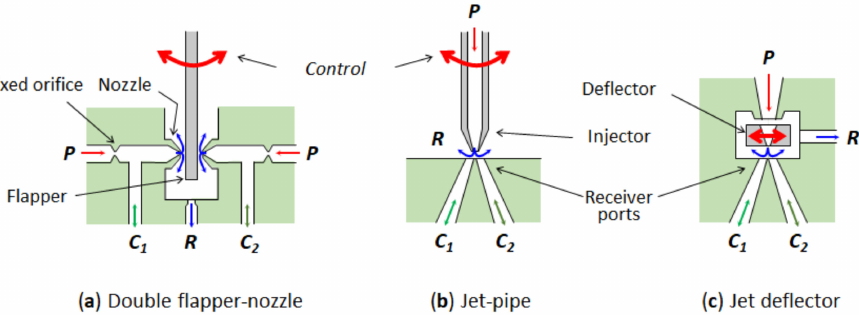
Figure 4. Hydraulic amplifiers used as pilot stages for servovalves: ( a ) Double flapper-nozzle; ( b ) Jet pipe; ( c ) Jet